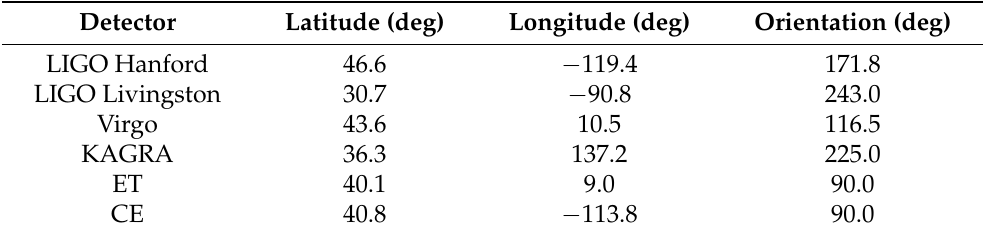
Table 1. Location coordinates and orientation angles for the detectors considered in this work. For the future 3G detectors ET and CE, we adopted arbitrary locations and orientations, assuming that the detectors will be built somewhere in one of their proposed sites: Sardinia (Italy) and Utah (USA), respectively. See [44] for further details on the definition of the coordinates and the orientation